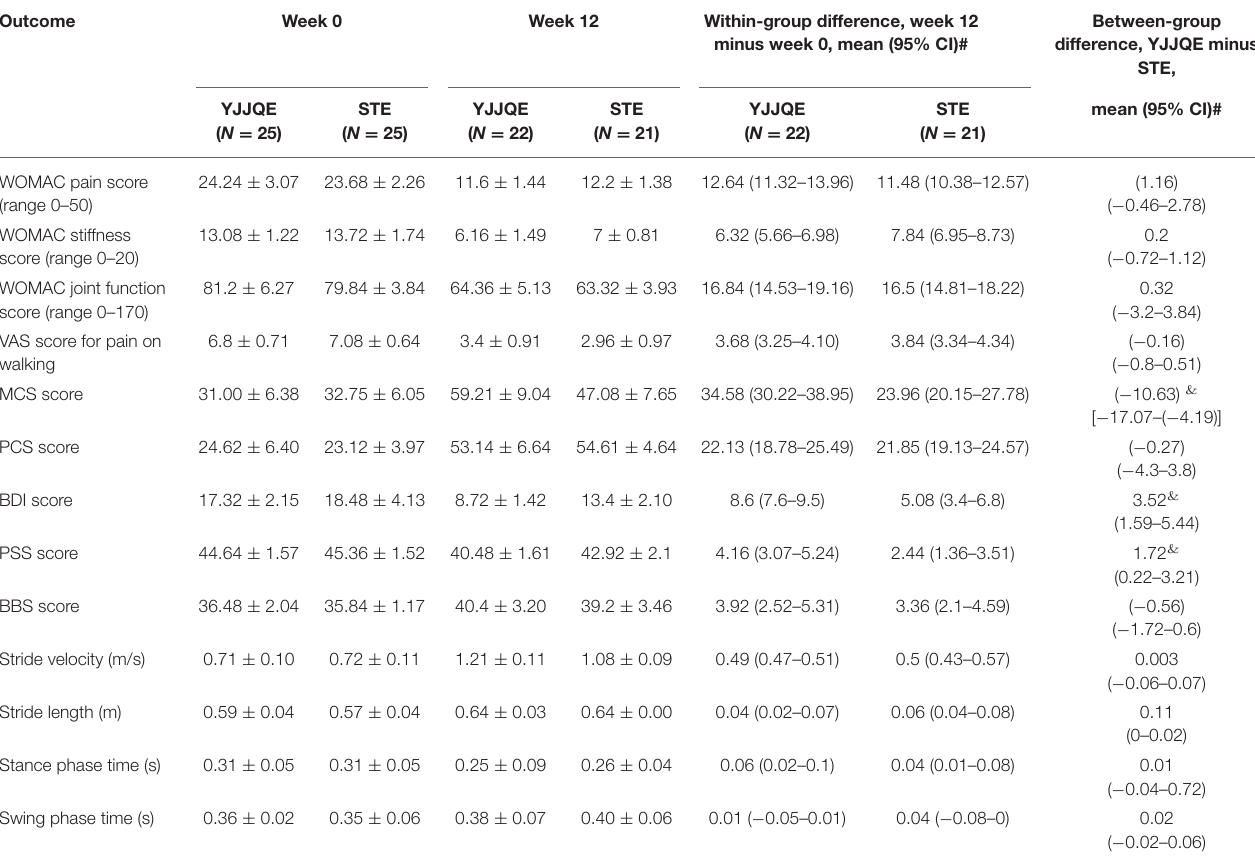
TABLE 4 | Outcome measures in the YJJQE and STE groups*. Outcome Week 0 Week 12 Within-group difference, week 12